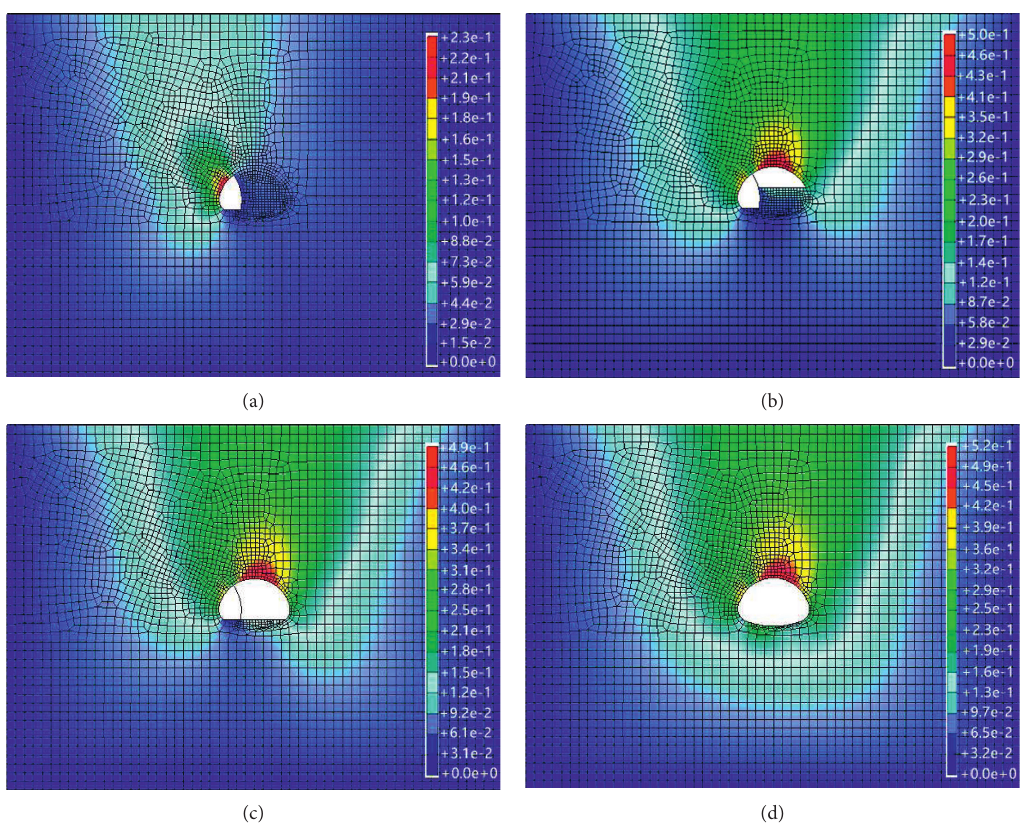
Figure 3: Settlement cloud diagram caused by the key steps of the double-side pilot pit. (a) Completion of the left pilot tunnel. (b) Completion of the upstairs. (c) Completion of the intermediate step. (d) All construction completed.